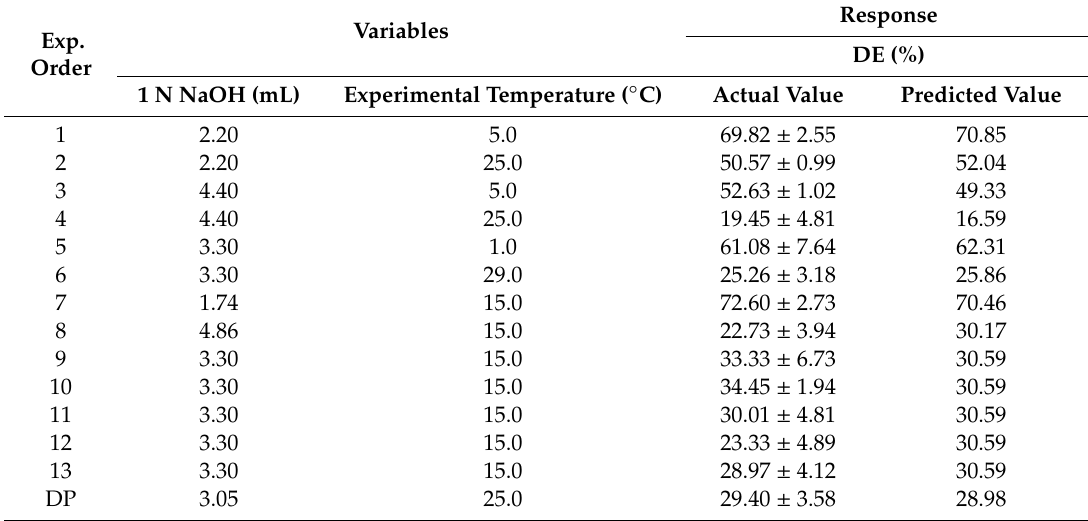
Table 3. The variable levels and responses of degree of esterification-based volume of NaOH and temperature. Exp.